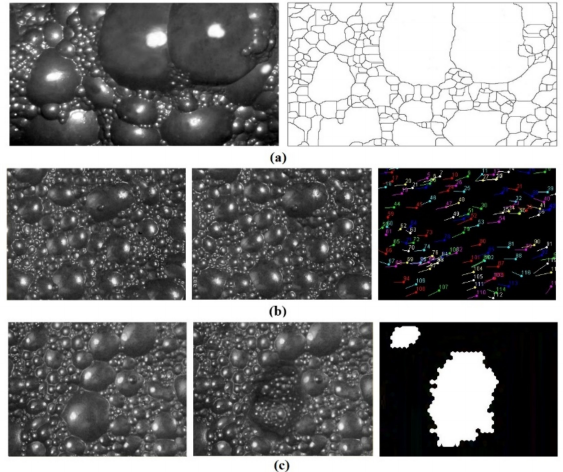
Figure 3. ( a ) The initial image after contrast enhancement and watershed algorithm; ( b ) froth transport rate measurement by the pixel tracing technique; ( c ) bubble burst rate